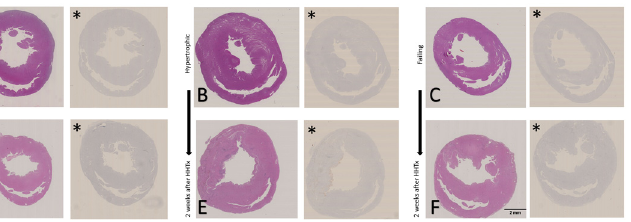
Fig 3. Left and right ventricular heart histology in transversal orientation and haematoxylin staining, Caspase-3 staining for evaluation of apoptotic myocyte numbers. A: Healthy heart of 3-weeks old Lewis rat B: Hypertrophic heart of 4-weeks old Lewis rat, 3 weeks after TAC with thickened myocardium C: Failing heart of 7-weeks old Lewis rat, 6 weeks after TAC with thinned myocardium D-F: Healthy heart (D), hypertrophic heart (E) and failing heart (F) of Lewis rat, after 2 weeks of mechanical unloading. * Caspase-3 staining of the respective image to the left. Representative